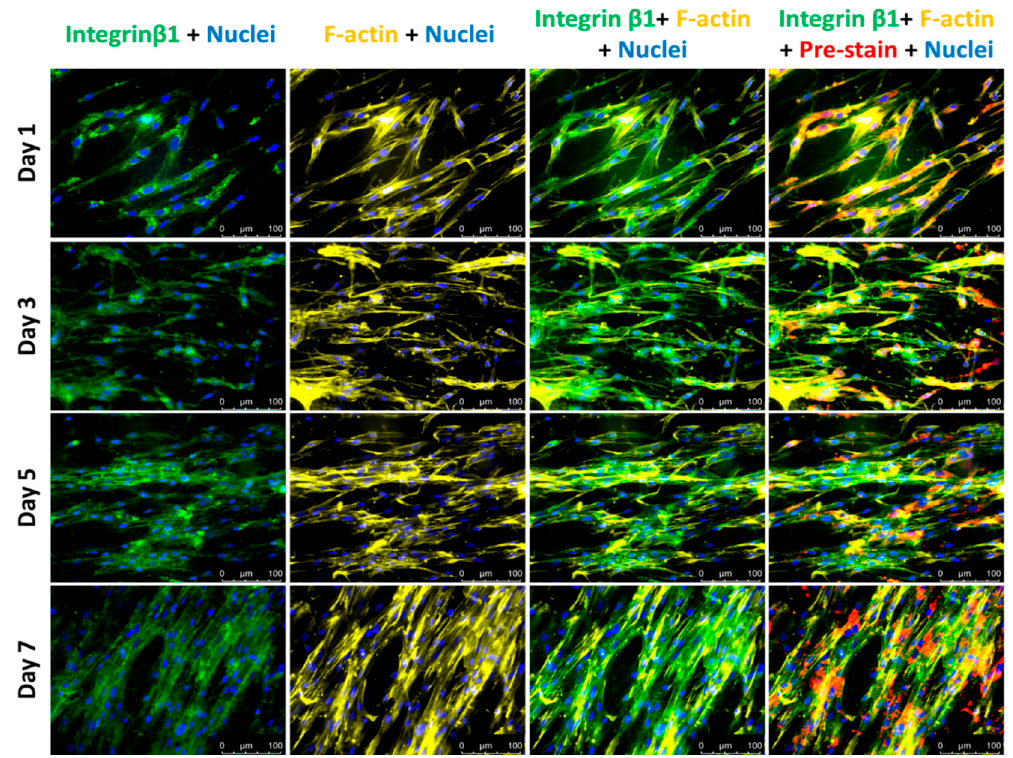
Figure 4. Fluorescent images of VICs in middle layer. Integrin β 1—Green; F-actin—Yellow; Nuclei—Blue; Cell membrane—Red. Scale bar: 100 µm.